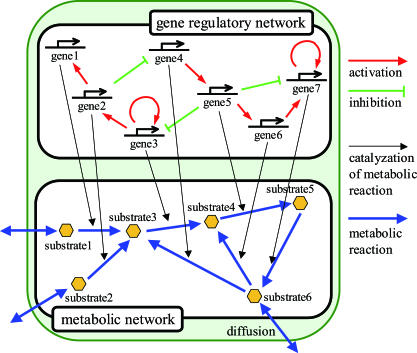
Schematic Representation of Our Cell ModelThe model consists of two networks, i.e., a gene regulatory network and a metabolic network. As a schematic example, simple networks consisted of n = 7 genes and m = 6 metabolic substrates are shown. The red arrows in the regulatory network represent activation of expressions, while green lines with blunt ends represent inhibition. The arrows from a gene to itself mean autoregulation of expressions. As a result of these regulatory interactions, the dynamics of expression levels of proteins have multiple attractors. The metabolic reactions, represented by blue arrows, are controlled by expression levels of corresponding proteins. The correspondence between metabolic reactions and gene products (proteins) are shown by the thin black arrows. The regulatory matrix Wij of the presented network takes W
21 = W
32 = W
33 = W
45 = W
56 = W
67 = W
77 = 1, W
24 = W
53 = W
57 = −1, and 0 otherwise. The reaction matrix Con(i,j,k) metabolic network takes a value 1 for the elements (1,3,1)(2,3,2)(3,4,3)(6,3,4)(4,5,5)(6,4,6)(5,6,7), and 0 otherwise. The choice of n = 7 in the figure is only for schematic illustration, and in the actual simulation we used much larger networks with n = 20 ∼ 100. In the present paper, we adopt a much larger network with n = 96 genes and m = 32 substrates.